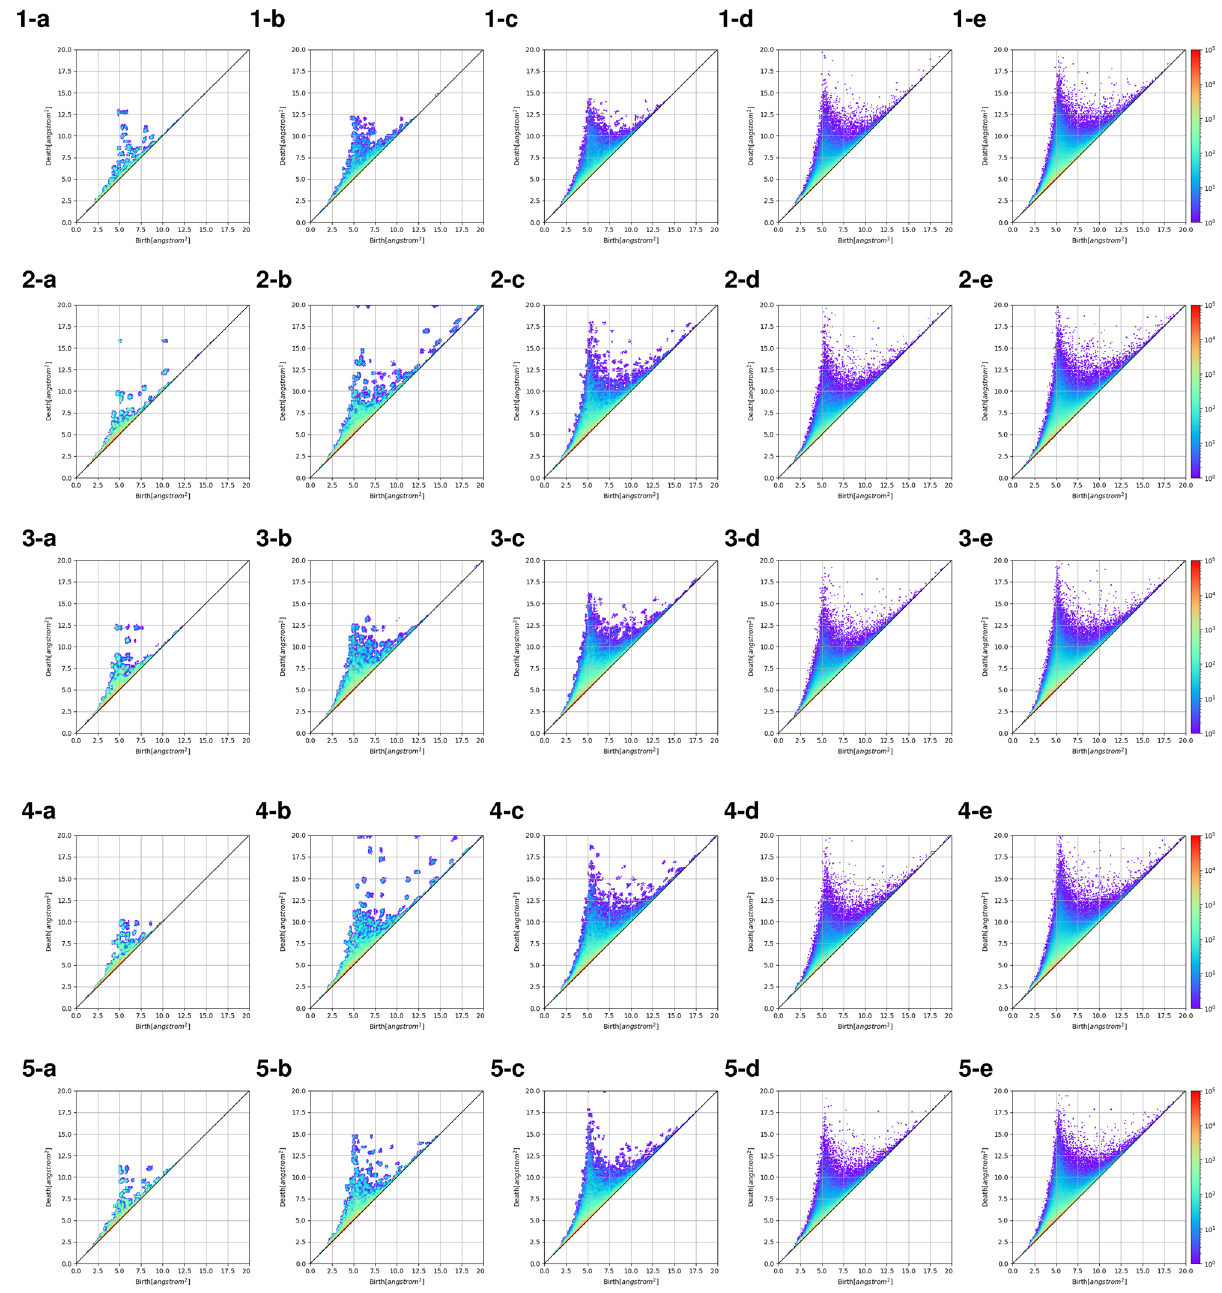
Figure 3. The change in the 2nd-order persistent diagrams with a hydrogen coordinate in each simulated cell size (2 nm to 30 nm). (a) 2 nm expand to 20 nm, (b) 4 nm expand to 20 nm, (c) 10 nm expand to 30 nm, (d) 20 nm, (e) 30 nm. Line 1 is sample 1. Line 2 is sample 2. Line 3 is sample 5. Line 4 is 10 mer in sample 1. Line 5 is 40 mer in sample